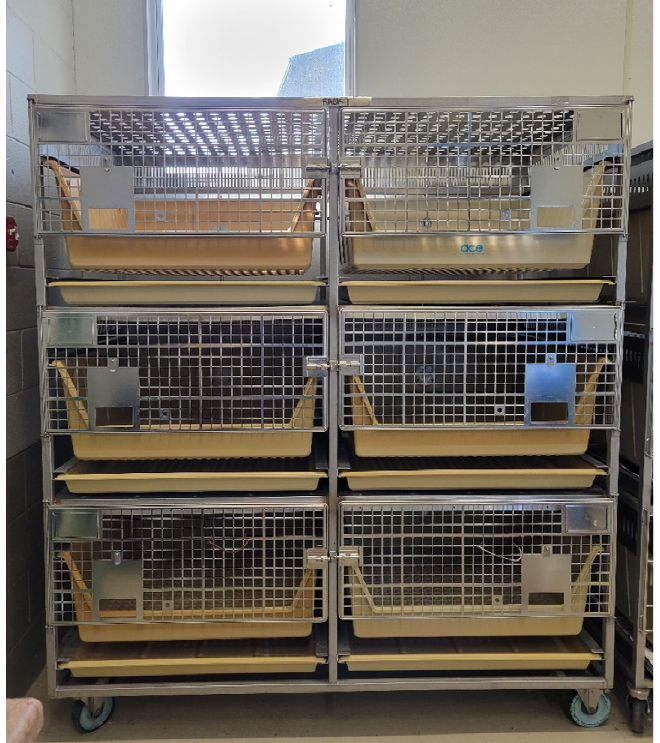
Figure 1. Laboratory ‐ style caging racks. This style of caging, where waste falls through into the liner below, provides a more hygienic space for the rabbits and allows for a much less invasive cleaning